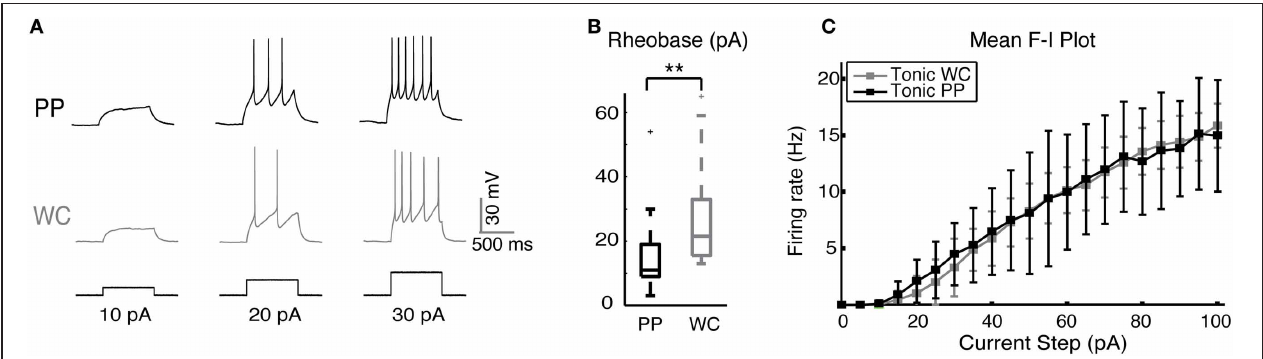
frequency of tonic PP (black, N = 9) and tonic WC (gray, N = 7) cells (instantaneous rate data not shown). The F-I relationship was not different in PP versus WC recordings (regression analysis, mean rate p = 0 . 80, instantaneous rate p = 0 .